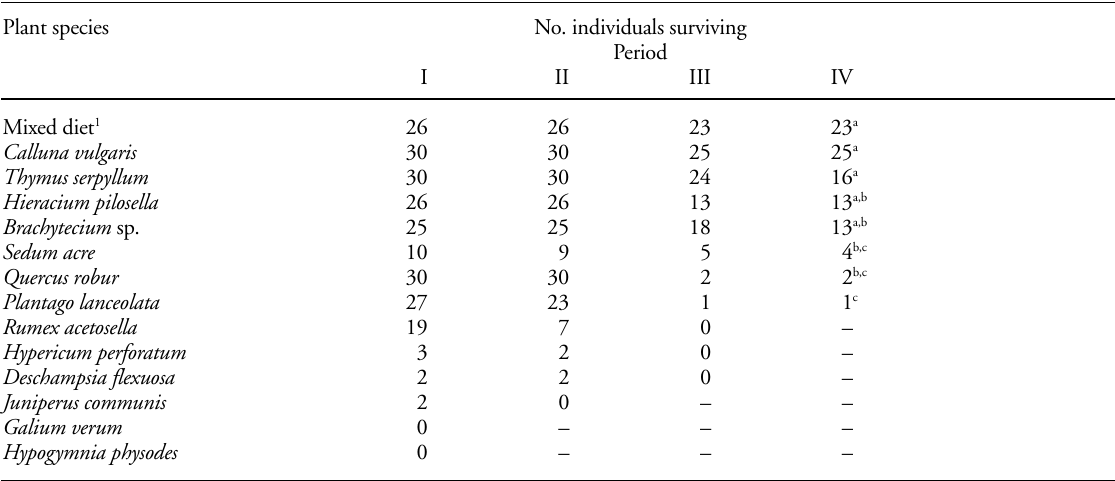
Table 1. Survival of D. ancilla on different plant species from hatched eggs to adults in a rearing experiment. Each cohort initially consisted of 30 larvae. Survival was observed during four periods: I) from start of the experiment to onset of hibernation, II) hiberna- tion, III) end of hibernation to pupation, and IV) the time spent as pupa to eclosion of the adult moth. Plant species No. individuals surviving Period